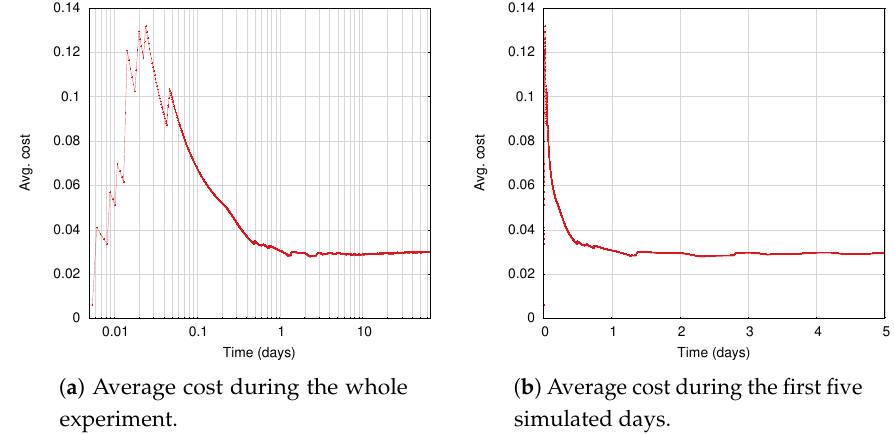
Figure 7. Average cost incurred over time by the RL-based Region Managers when using the RL-based policy for the ACS. The learning algorithm quickly converges after about the first simulated